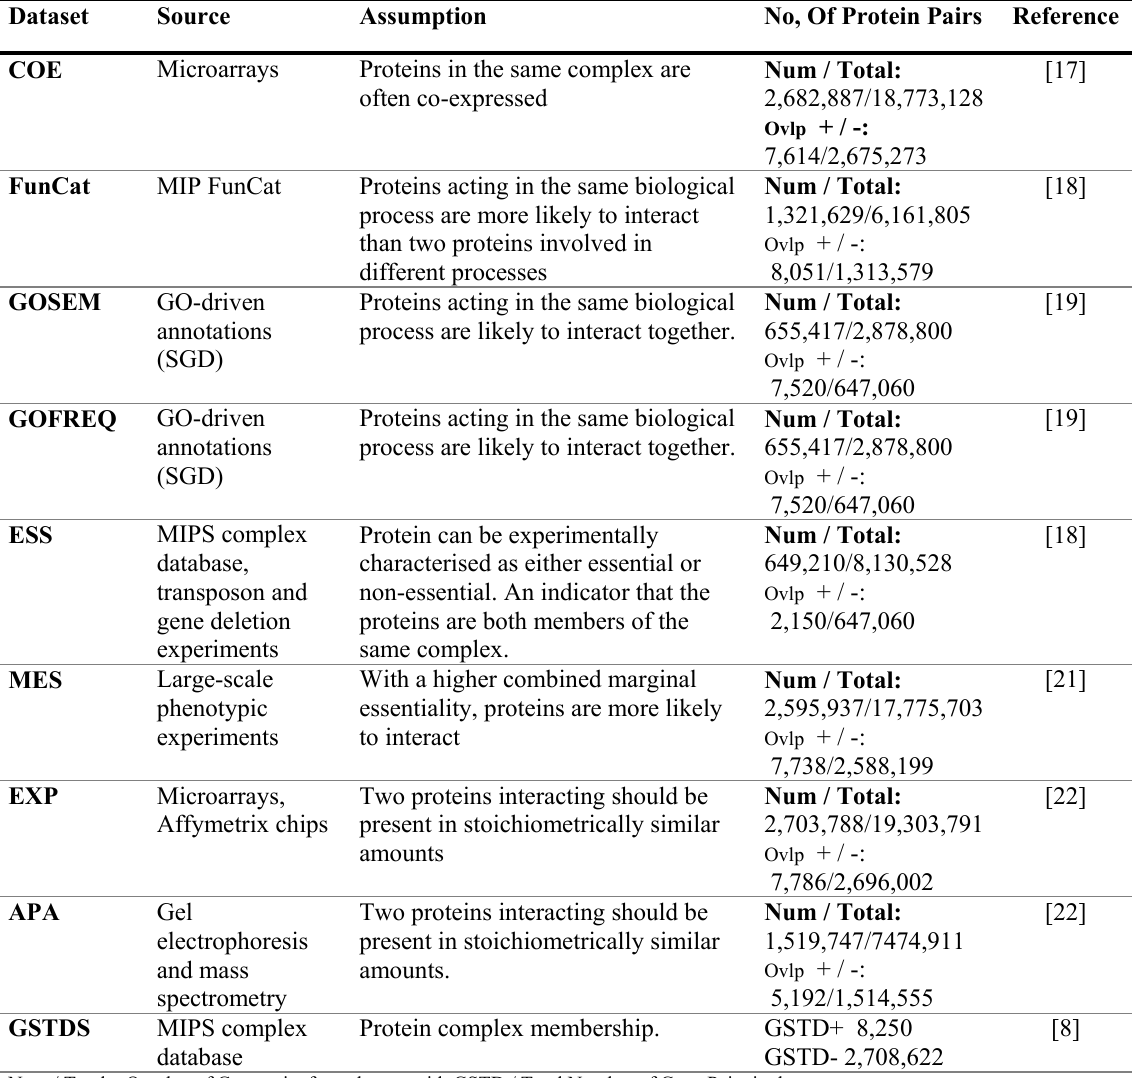
Table 1 - Summary of functional datasets assessed for PPI integrative prediction